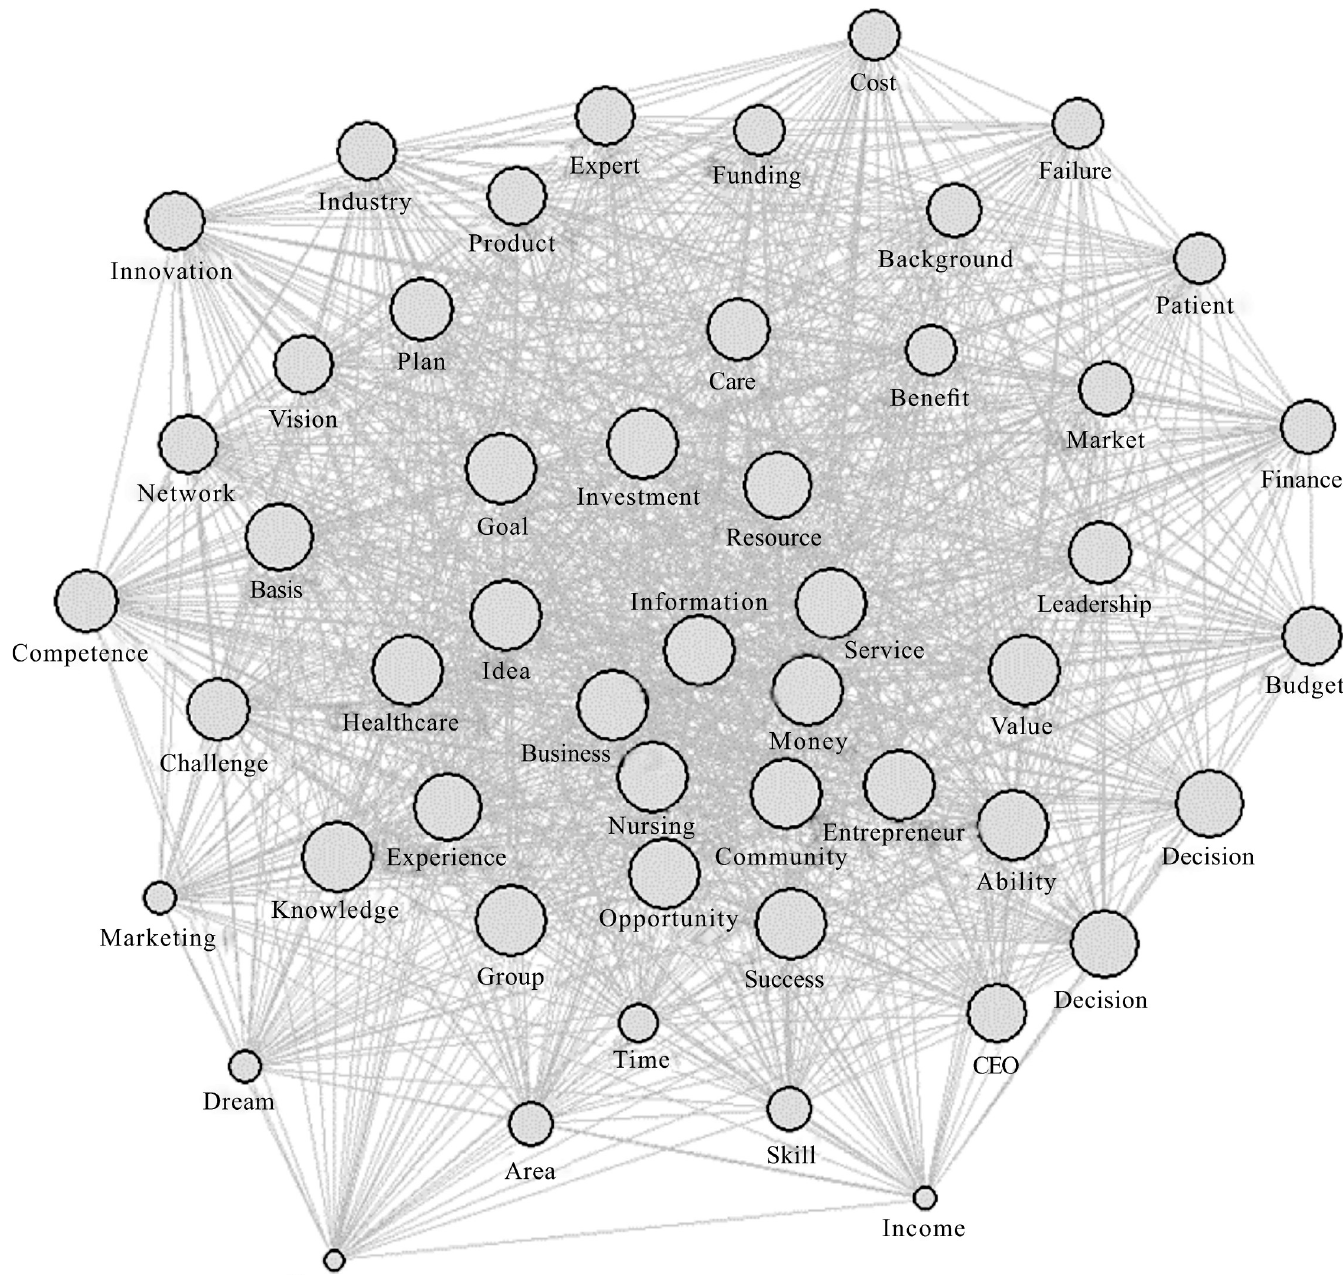
Fig 2. Sociogram of top 50 keywords in degree